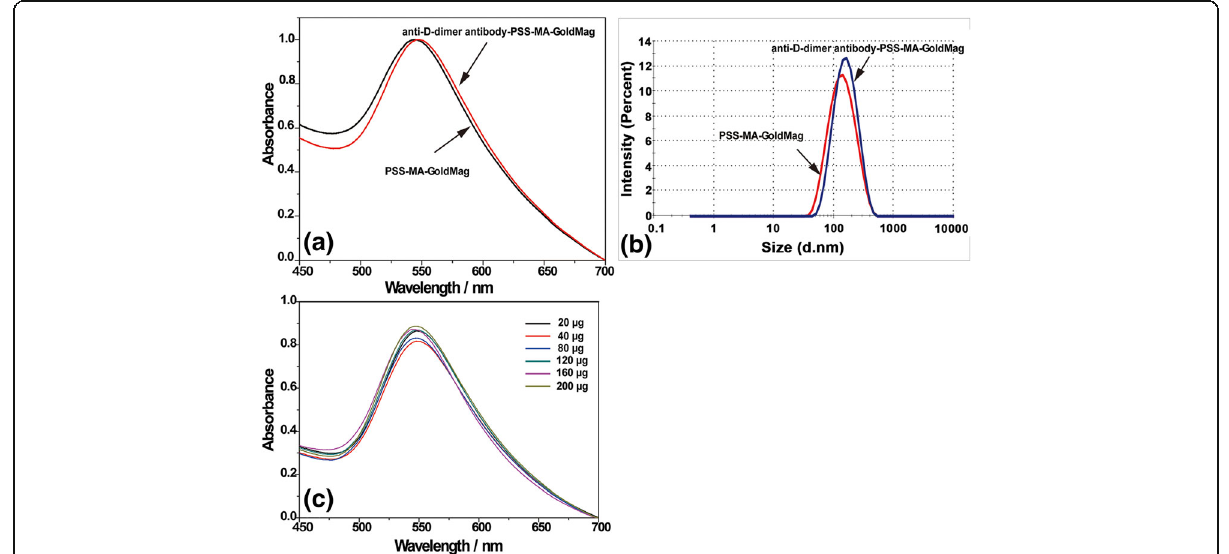
Fig. 4 a The SPR spectra of PSS-MA-GoldMag and anti-D-dimer antibody-PSS-MA-GoldMag. b The size distribution of antibody-PSS-MA-GoldMag and PSS-MA-GoldMag. c The SPR peak of particles was not changed with increasing antibody